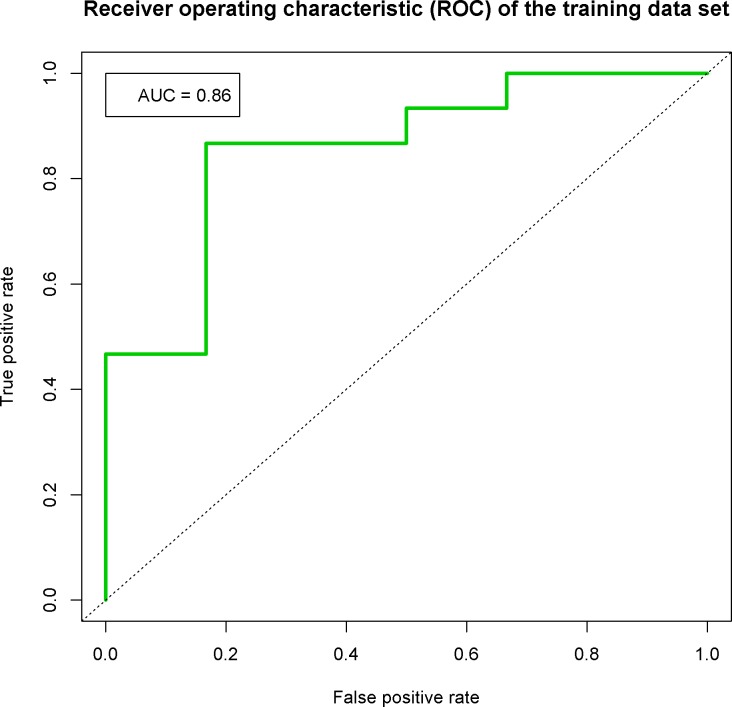
ROC curve of the training set.Receiver operating characteristic (ROC) curve for the binary classifier built to distinguish between live birth (LB) and no pregnancy (NP). The curve shows the true positive rate versus false positive rate, i.e. the tradeoff between sensitivity and specificity. The area under the curve (AUC), which captures the ability of the classifier to correctly group the patients with follicular adenoma and those with follicular carcinoma, is equal to 0.86. A perfect classifier will have an AUC of 1.0, whereas an AUC value of 0.5 indicates that the classification is random.